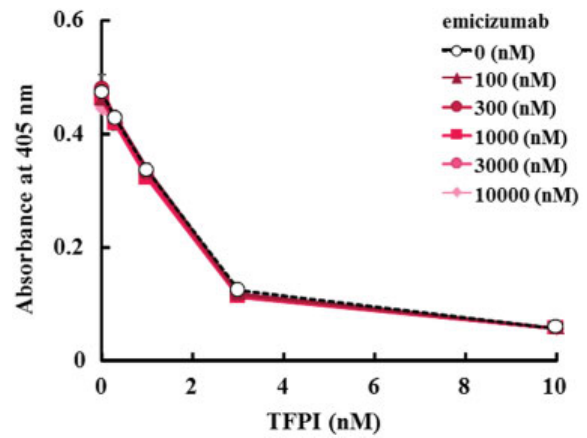
Fig. 2 Effect of emicizumab on the action of TFPI on FXa in enzymatic assays. Emicizumab ’ s effect on the action of TFPI on FXa in the FXa inhibition assay. Data are expressed as mean (cid:2) SD ( n ¼ 3). The bars depicting SD are shorter than the height of the symbols. The symbols for the groups with higher concentrations of emicizumab are hidden behind the symbols for the other